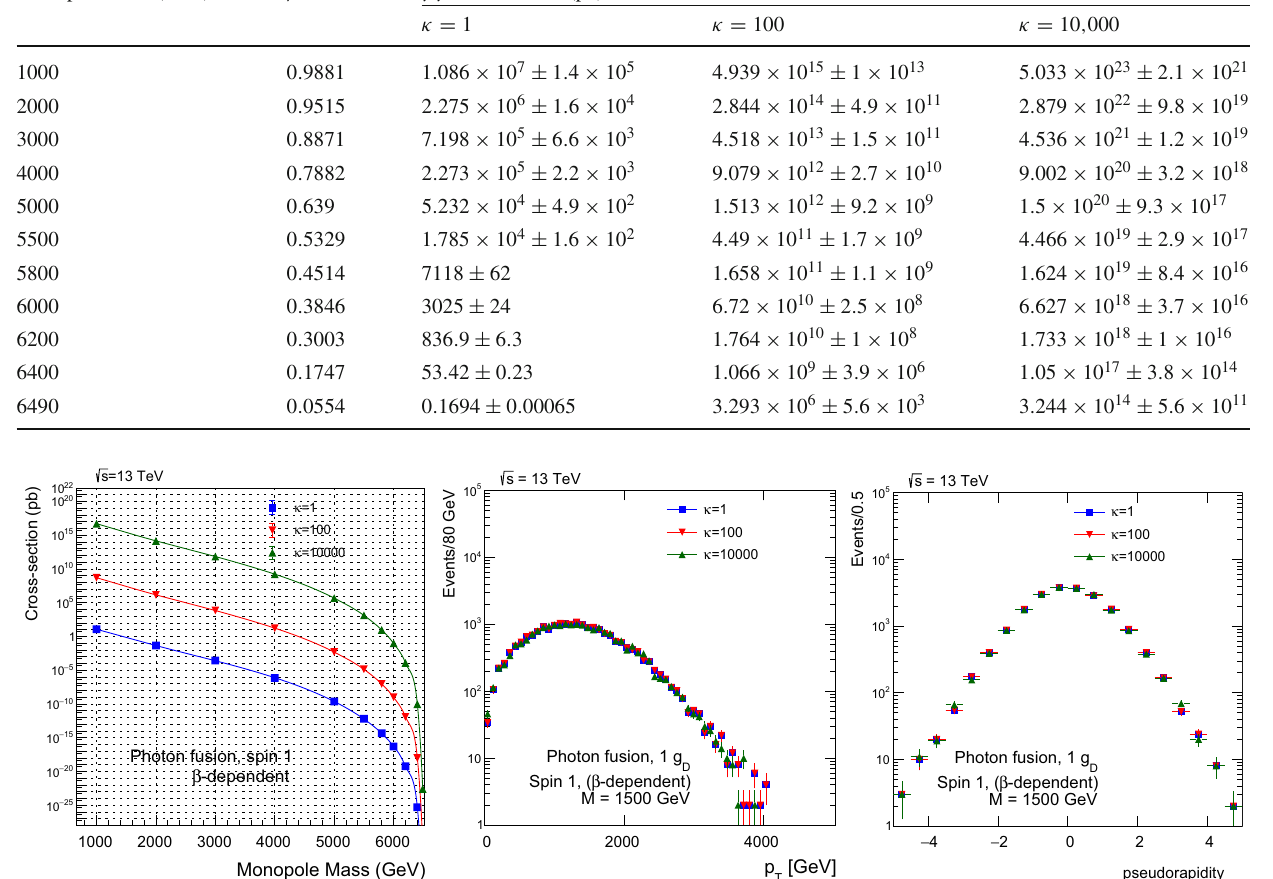
Table 4 Photon-fusion production cross sections at parameter Monopole mass (GeV)